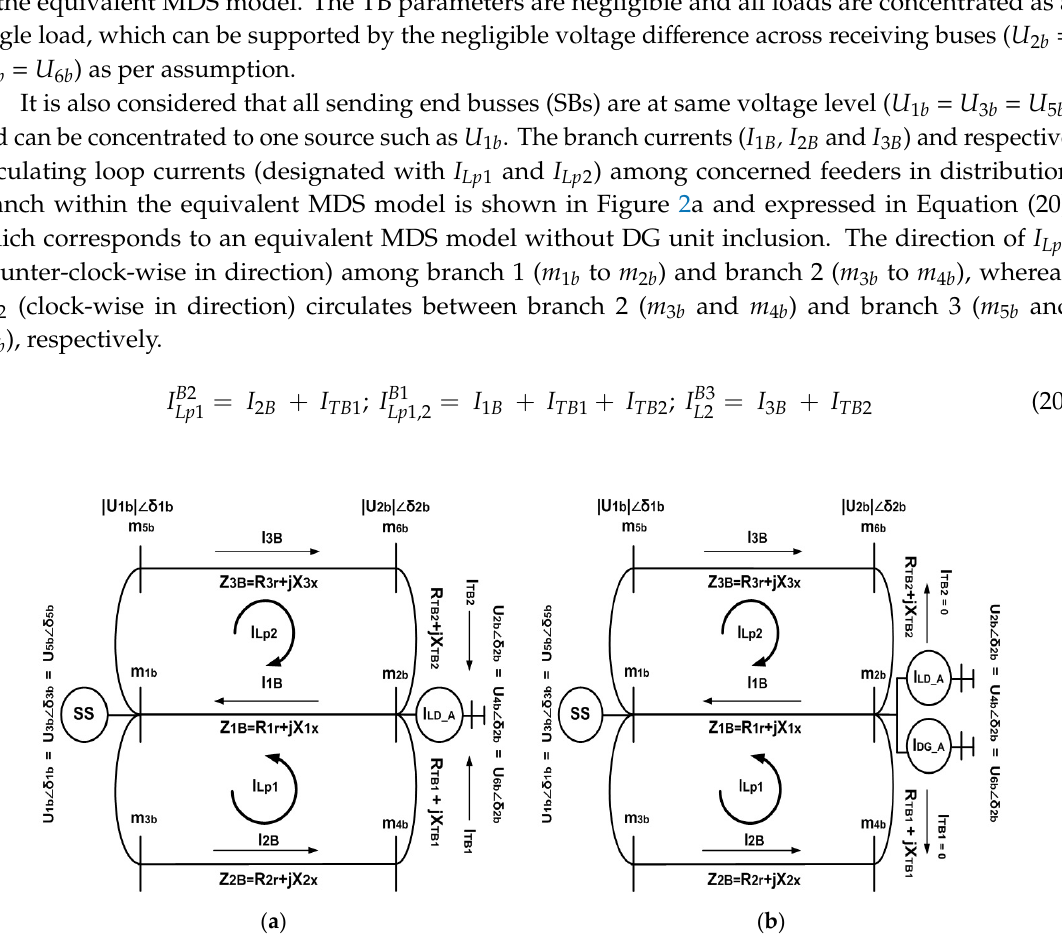
Figure 2. ( a ) Electrical equivalent model for MDS with circulating loop currents without loss minimization condition (LMC); ( b ) Electrical equivalent model for MDS aiming at LMC with DG.